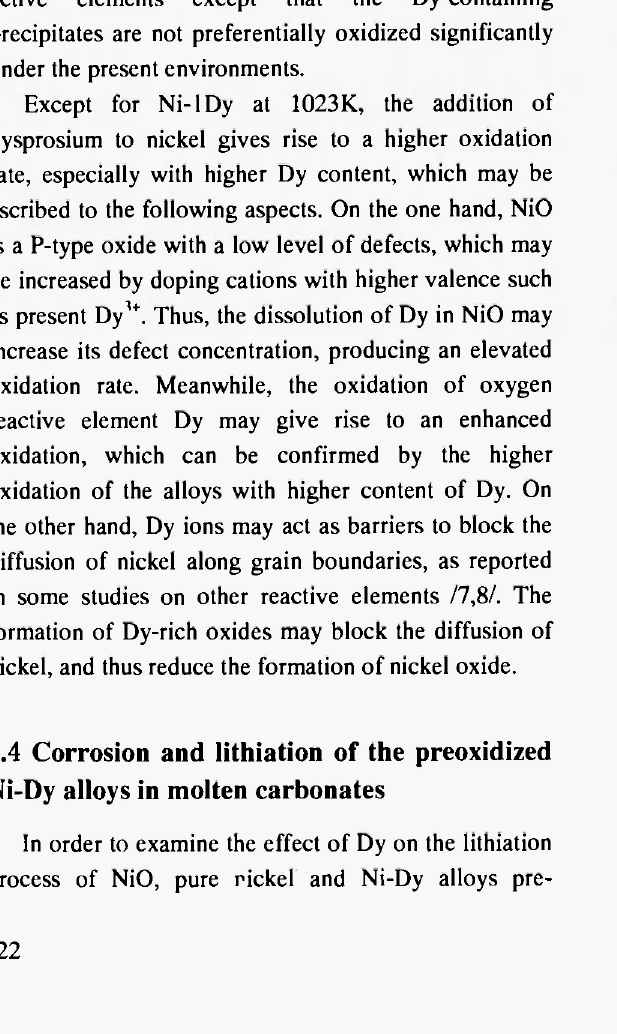
metallic nickel with some Y 2 0 3